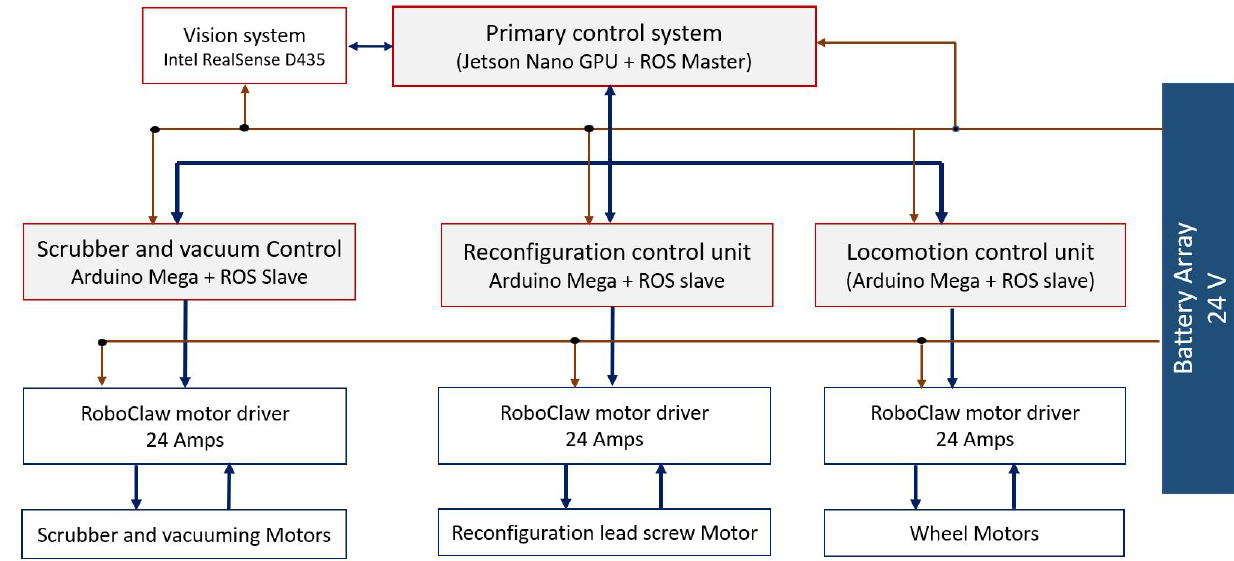
Figure 4. Hardware